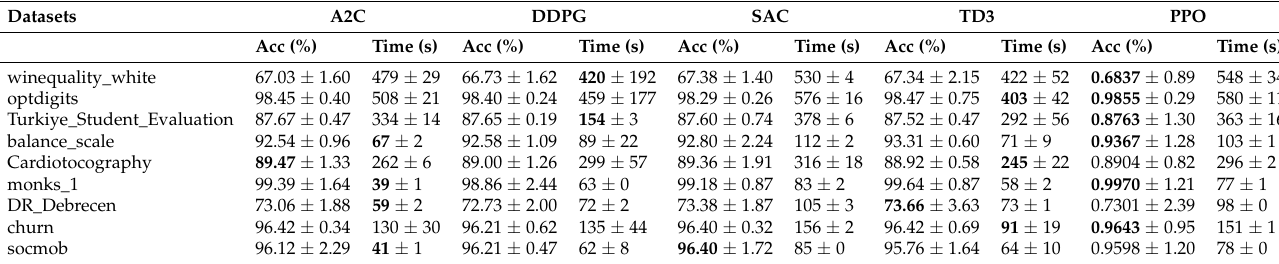
Table 6. The performance (mean ± std) of our method with different RL algorithms.